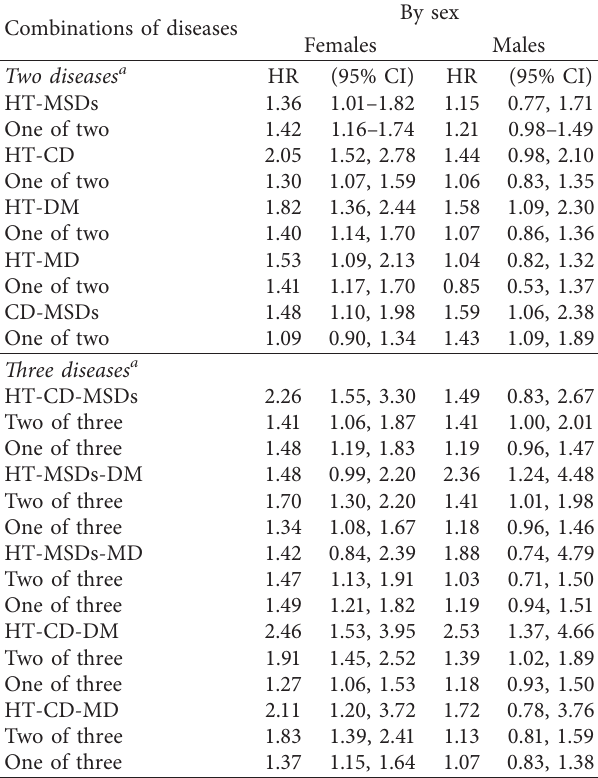
Table 4: Adjusted hazard ratios ∗ (95% confidence intervals) for all- cause mortality according to combinations of two and three chronic diseases by sex (SABE study, municipality of São Paulo, 2000).